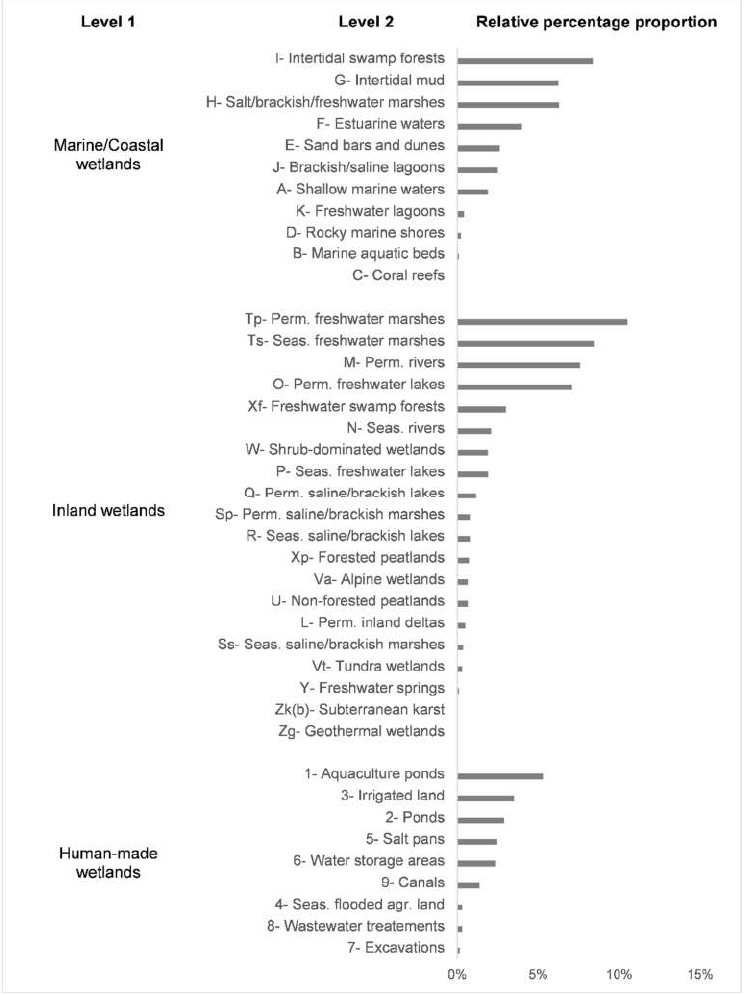
Figure 4. Percentage of wetland types investigated in the reviewed studies classified by levels 1 and 2 of the Ramsar wetland classification [16]. Seas .: seasonal; Perm. : permanent.